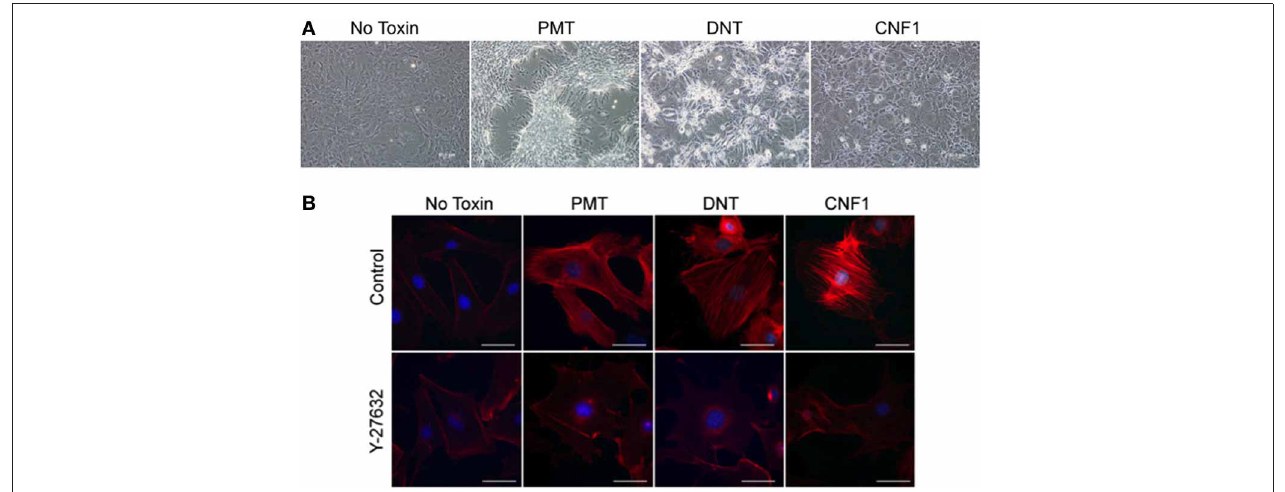
FIGURE 1 | Effect of dermonecrotic toxins on 3T3-L1 preadipocyte cell morphology and stress fiber formation. (A) Phase-contrast images of confluent, undifferentiated 3T3-L1 cell monolayers treated continuously for 5 dayswith 0.5nMof theindicatedtoxin. (B) Fluorescencemicroscopyimages